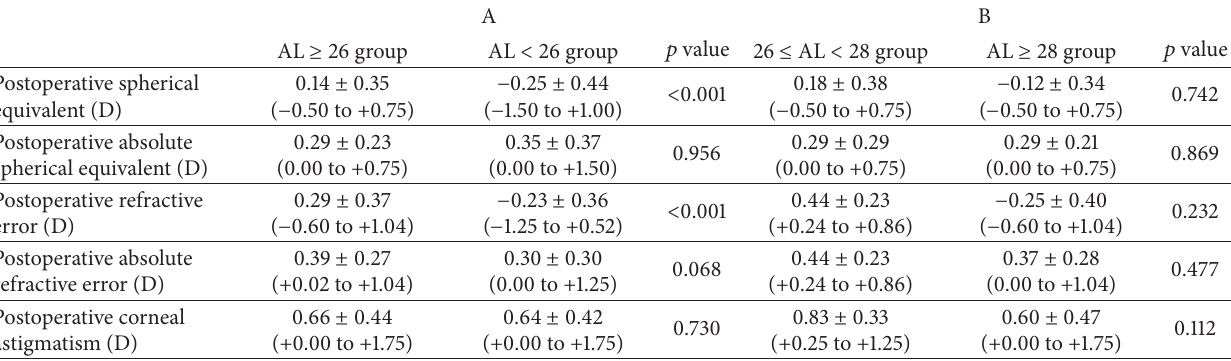
Table 2: Postoperative refractive data. (A) Patients were stratified into axial length of 26 or above (AL ≥ 26 group) and below 26mm (AL < 26 group). (B) Eyes in AL ≥ 26 group were further divided into 26 ≤ AL < 28 group and AL ≥ 28